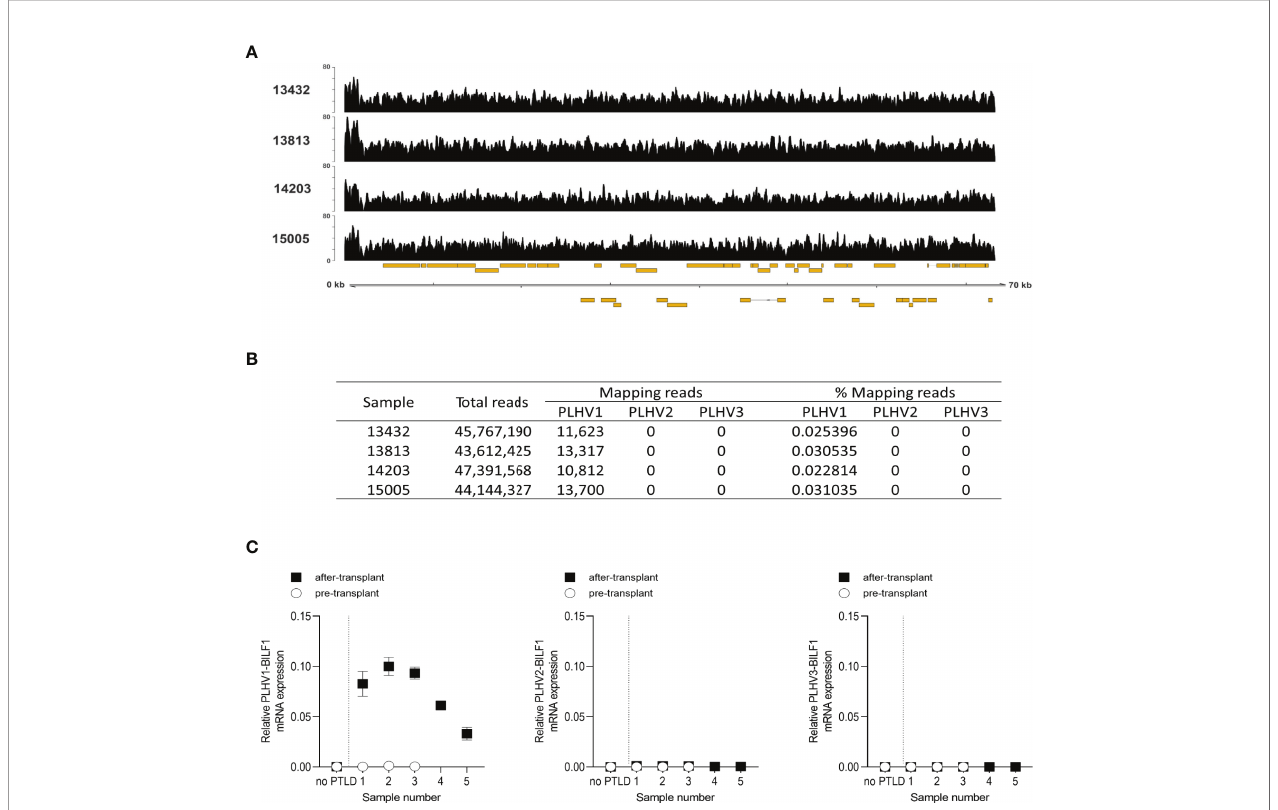
FIGURE 6 | High expression levels of PLHV1 and PLHV1-BILF1 detected in PTLD-diseased pigs. (A) Illumina sequencing of PTLD samples allowed the identi fi cation of a small number of sequence reads aligning to the PLHV1 UL region. Coverage plots are shown for each sample and show an even distribution across the genomic fragment. The y-axis scale indicates read depth while the x-axis shows the genome fragment along with annotated ORFs (gold boxes). (B) Competitive alignment of Illumina sequence reads derived from tumours, against PLHV1, PLHV2, and PLHV3 genome fragments. (C) The expression levels of PLHV1-3 BILF1 were determined by qPCR using cDNA from lymphoid tissue samples of PTLD diseased pigs collected before and after disease onset. Results are mean ± SEM of raw data and presented as 2 D Ct